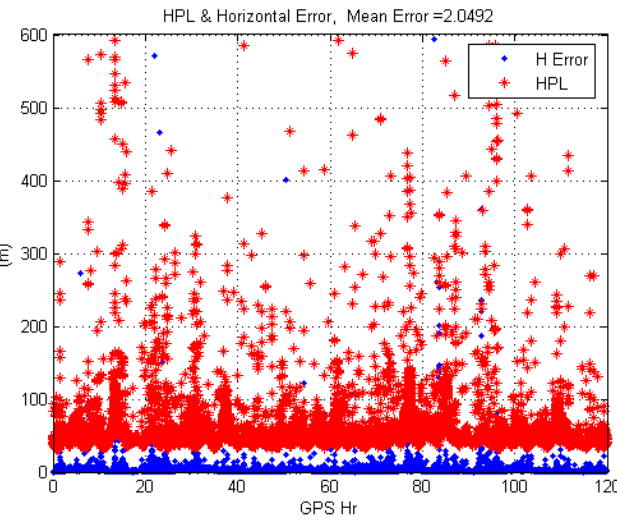
Figure 23. The HPL and horizontal position error in Taipei FIR (3 RSs).